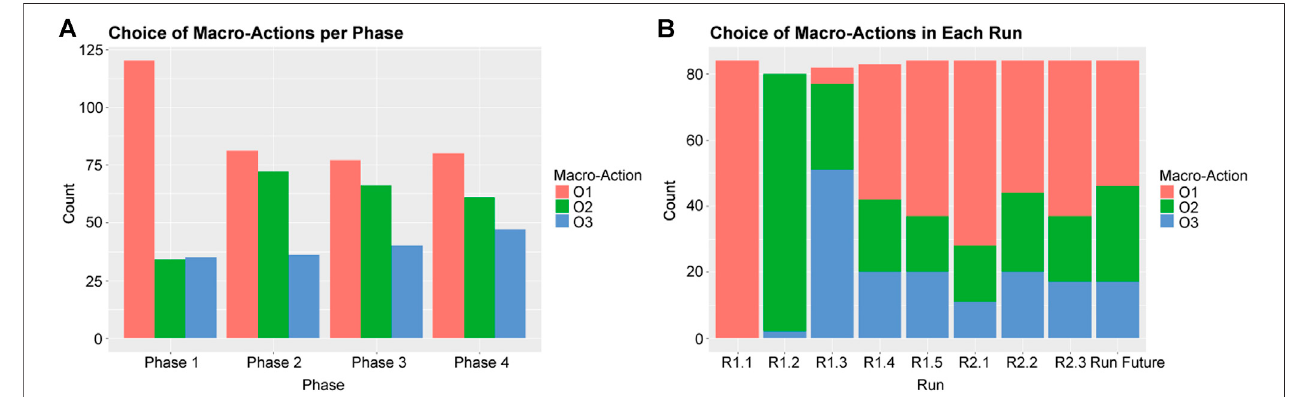
FIGURE 8 | An overview of how often certain Macro-actions were chosen by the robot across all participants per phase (A) and per run (B) .